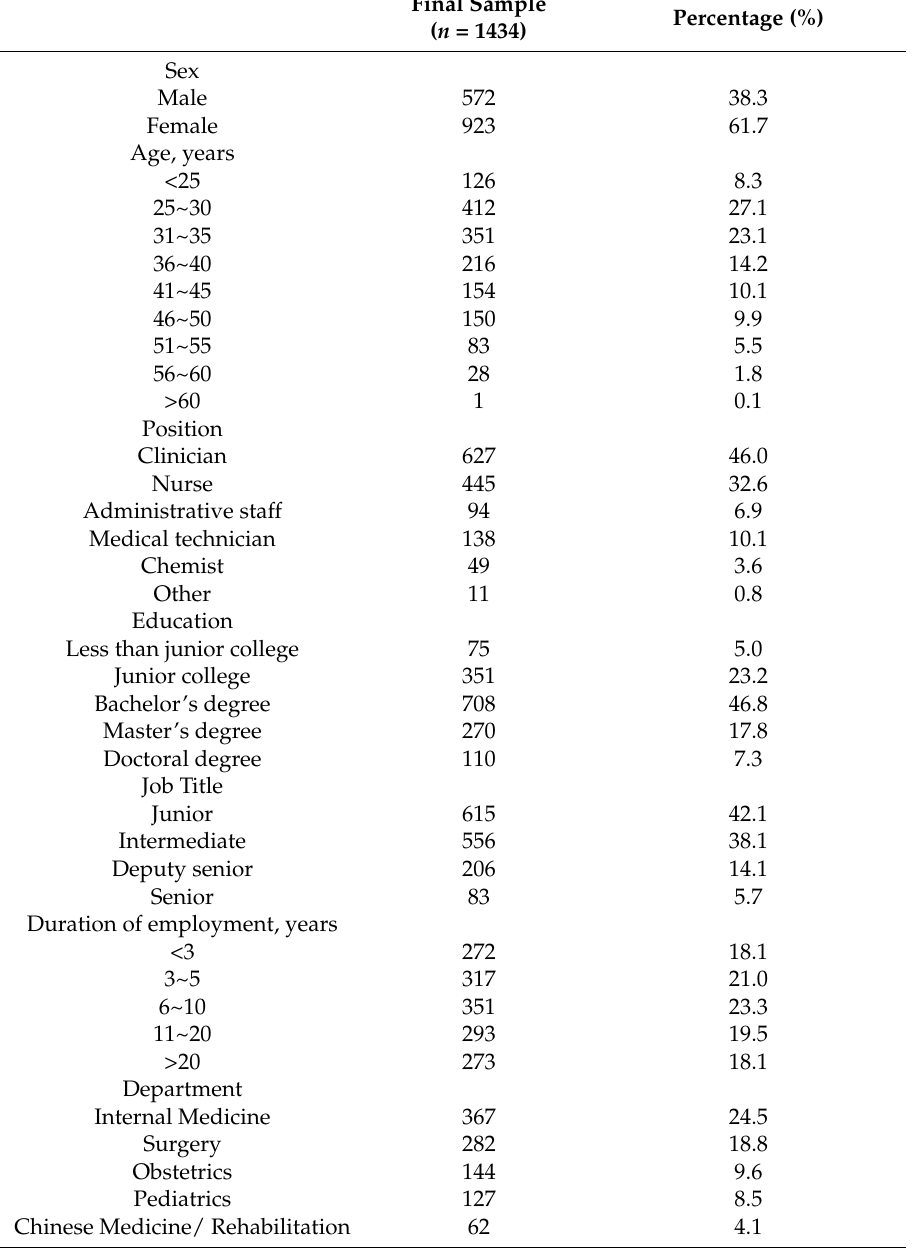
Table 1. Demographic characteristics of the